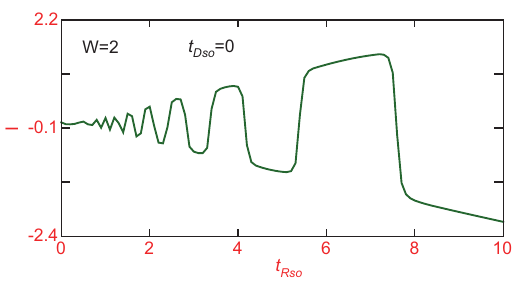
Figure 22 Persistent current at a particular AB fl ux ( φ = 0.25) as a Figure 20 Persistent current at a particular AB fl ux ( φ = 0.25) as function of Rashba SO interaction strength for a disordered ( W = 2) a function of Rashba SO interaction strength for an ordered ( W = 0) is set to half-fi lled ring with N = 60 when t is set to zero. half-fi lled ring with N = 60 when t Dso Dso